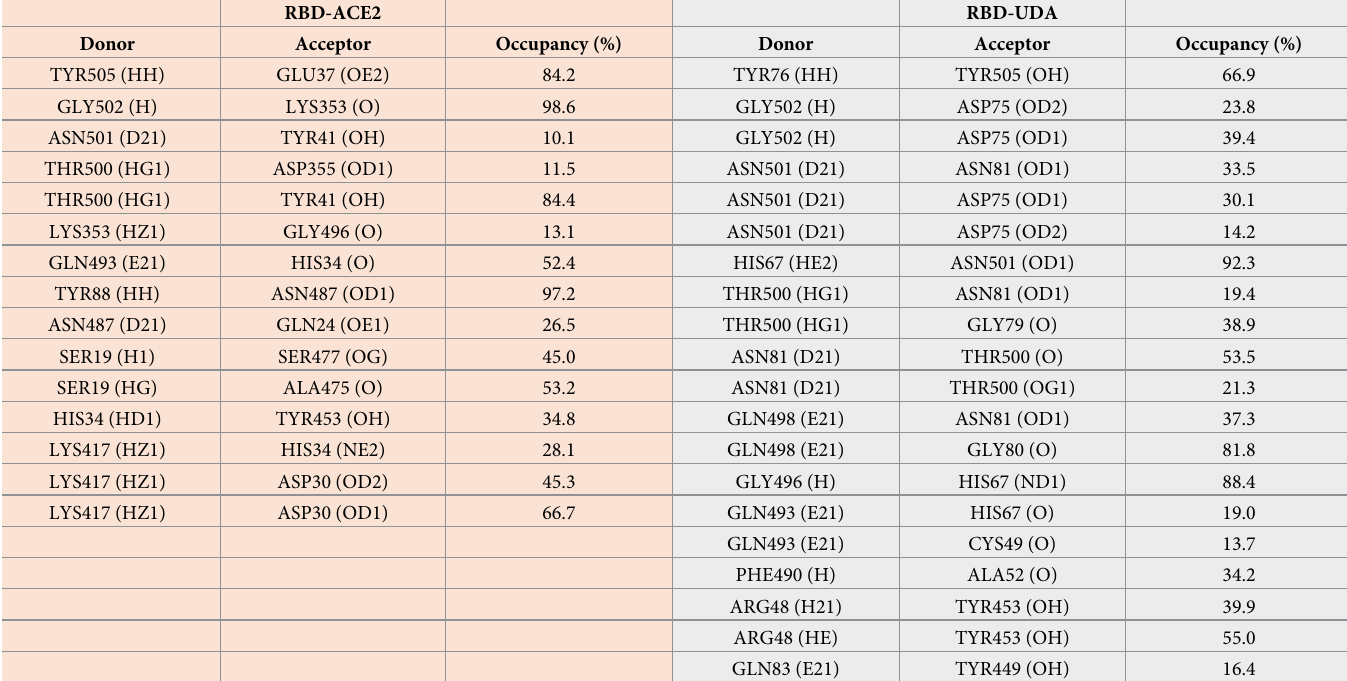
Table 3. Hydrogen bond occupancy between RBD and ACE2, RBD and UDA during 100ns molecular dynamic simulations.